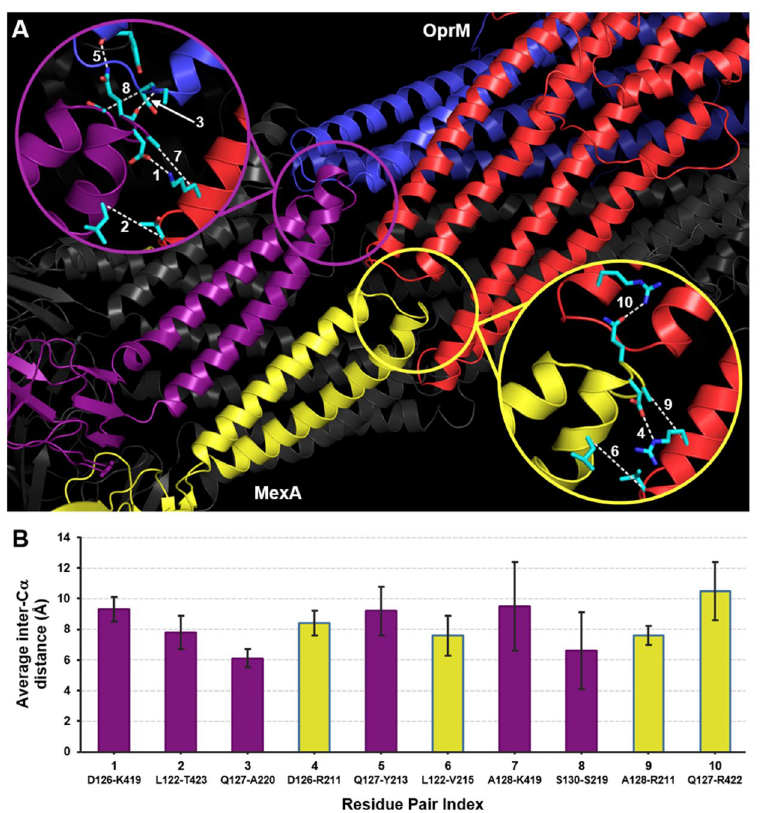
Figure 3. The top ten predicted residues pairs from sequence covariation analysis are found at two adjacent interfaces between MexA and OprM. ( A ) One interface (top-left inset) involves the α -hairpin of a MexA monomer (violet) intercalating between two α -hairpins from separate OprM monomers (blue and red). The other interface (bottom-right inset) involves the α -hairpin of a MexA monomer (yellow) intercalating between two α -hairpins from the same OprM monomer (red). Six of the ten predicted residue pairs occur in the former interface, while the other four are found in the latter interface. Numbers in both insets refer to the GREMLIN ranking of each residue pair (see Table 1). For this snapshot, dashed lines show: (i) SC-SC contacts for pairs 1, 4, and 10; (ii) SC-BB contacts for pairs 3, 5, and 8; and (iii) inter-C α distances for pairs 2, 6, 7, and 9. ( B ) Average inter-C α distances for each of the ten residue pairs over all three protomers in the last 500 ns of the 1- μ s MD simulation of MexAB-OprM. Residue pairs are colored either violet or yellow depending to which of the two interfaces shown in ( A ) these belong. Error bars give